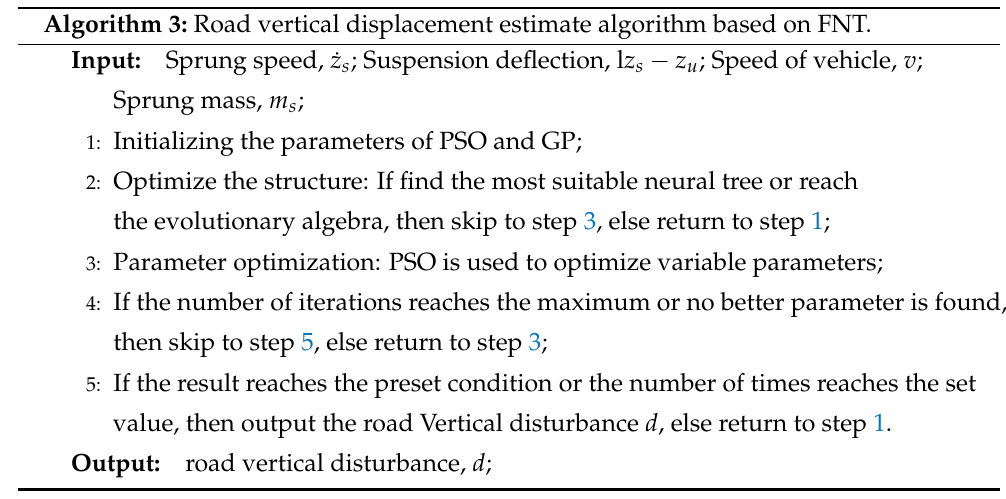
Algorithm 3: Road vertical displacement estimate algorithm based on